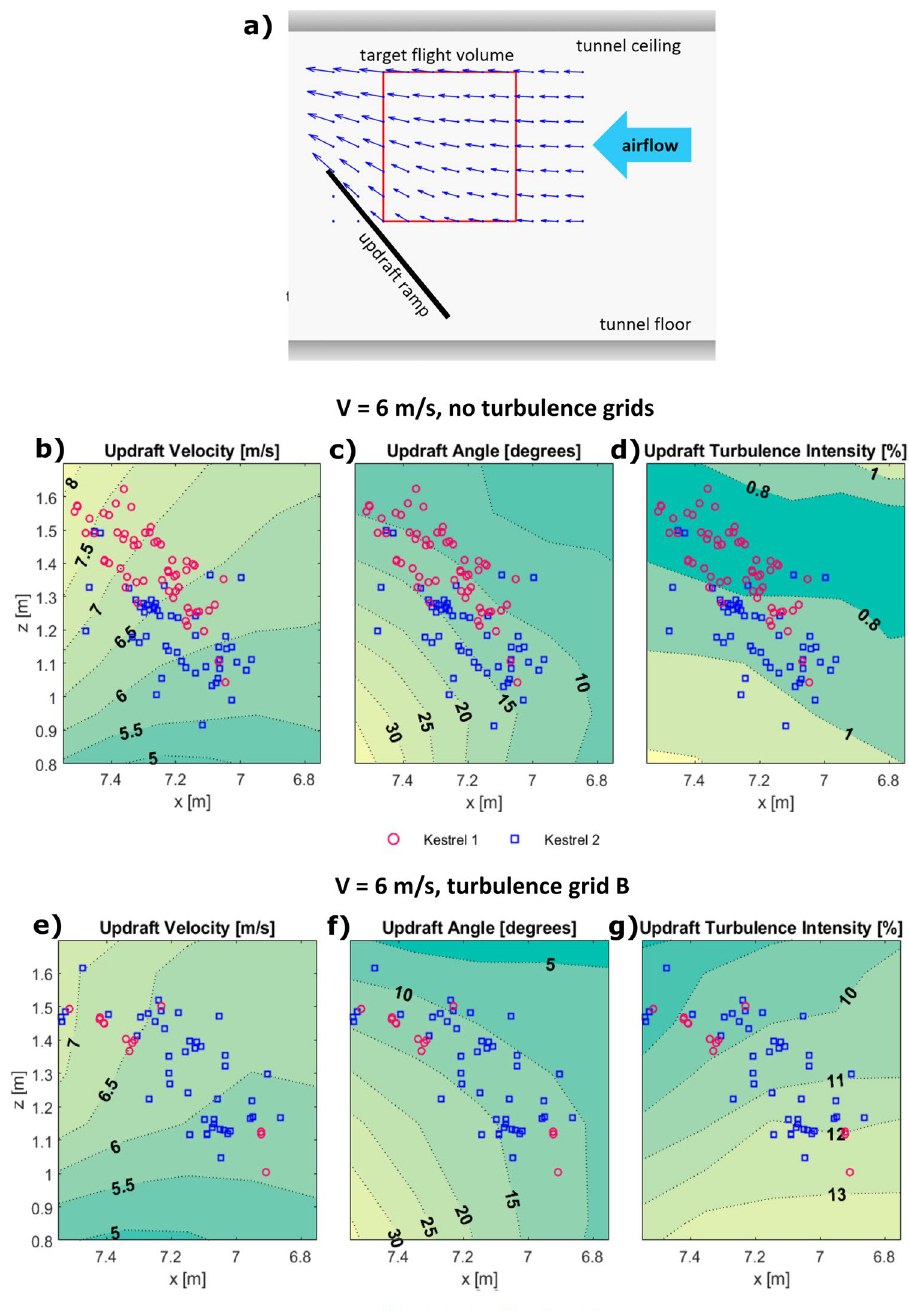
Figure 3. Results of flow mapping and flight testing conducted at a tunnel speed of 6 m/s. ( a ) A scale diagram depicting the relative positioning of the flight volume and ramp within the wind tunnel. Blue arrows indicate the measured flow velocity vectors at measurement locations shown in Fig. 2c. A silhouette indicates the size of a kestrel. ( b – d ) Contours of the flow velocity, updraft angle and turbulence intensity without turbulence grids present. Markers indicate the location of the mantle of each kestrel during a hanging flight. ( e – g ) Contours of the flow velocity, updraft angle and turbulence intensity with turbulence grid B